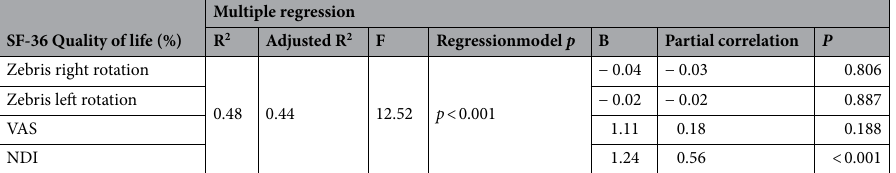
Table 7. Assessment of mental dimension quality of life depending on range of rotation, pain intensity and disability level (Zebris / VAS / NDI). R 2 , regression model; Adjusted R 2 , regression model, removes extreme values; F, Fisher’s test result; b, regression coefficient; partial correlation, the variable Xi is correlated with the variable Y after accounting for effects of all the remaining independent variables (simultaneous effect of all the four factors); p , significance